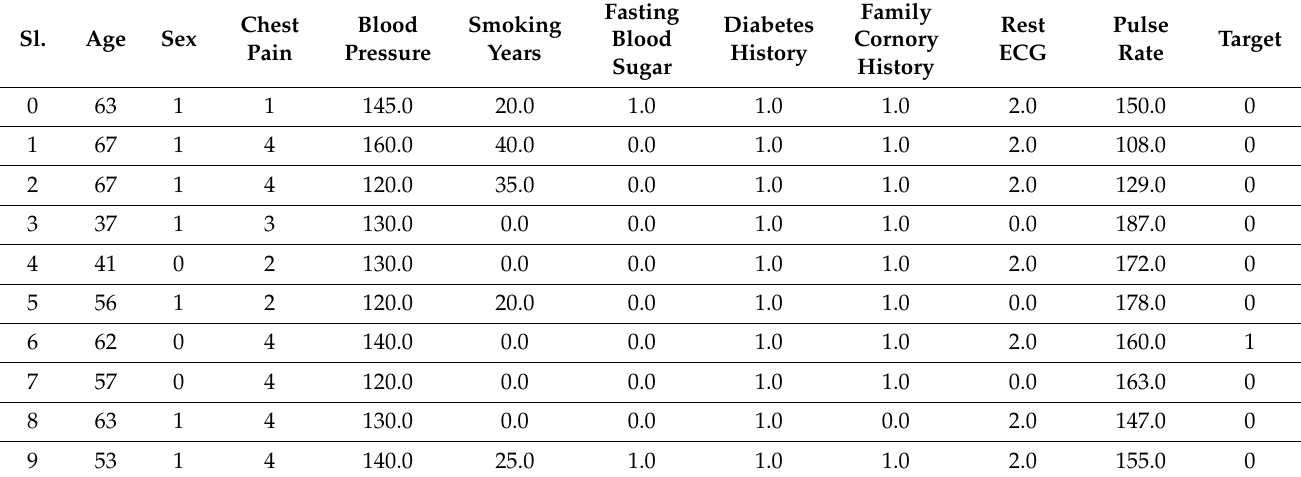
Table 4. Samples from pre-processed IHDD